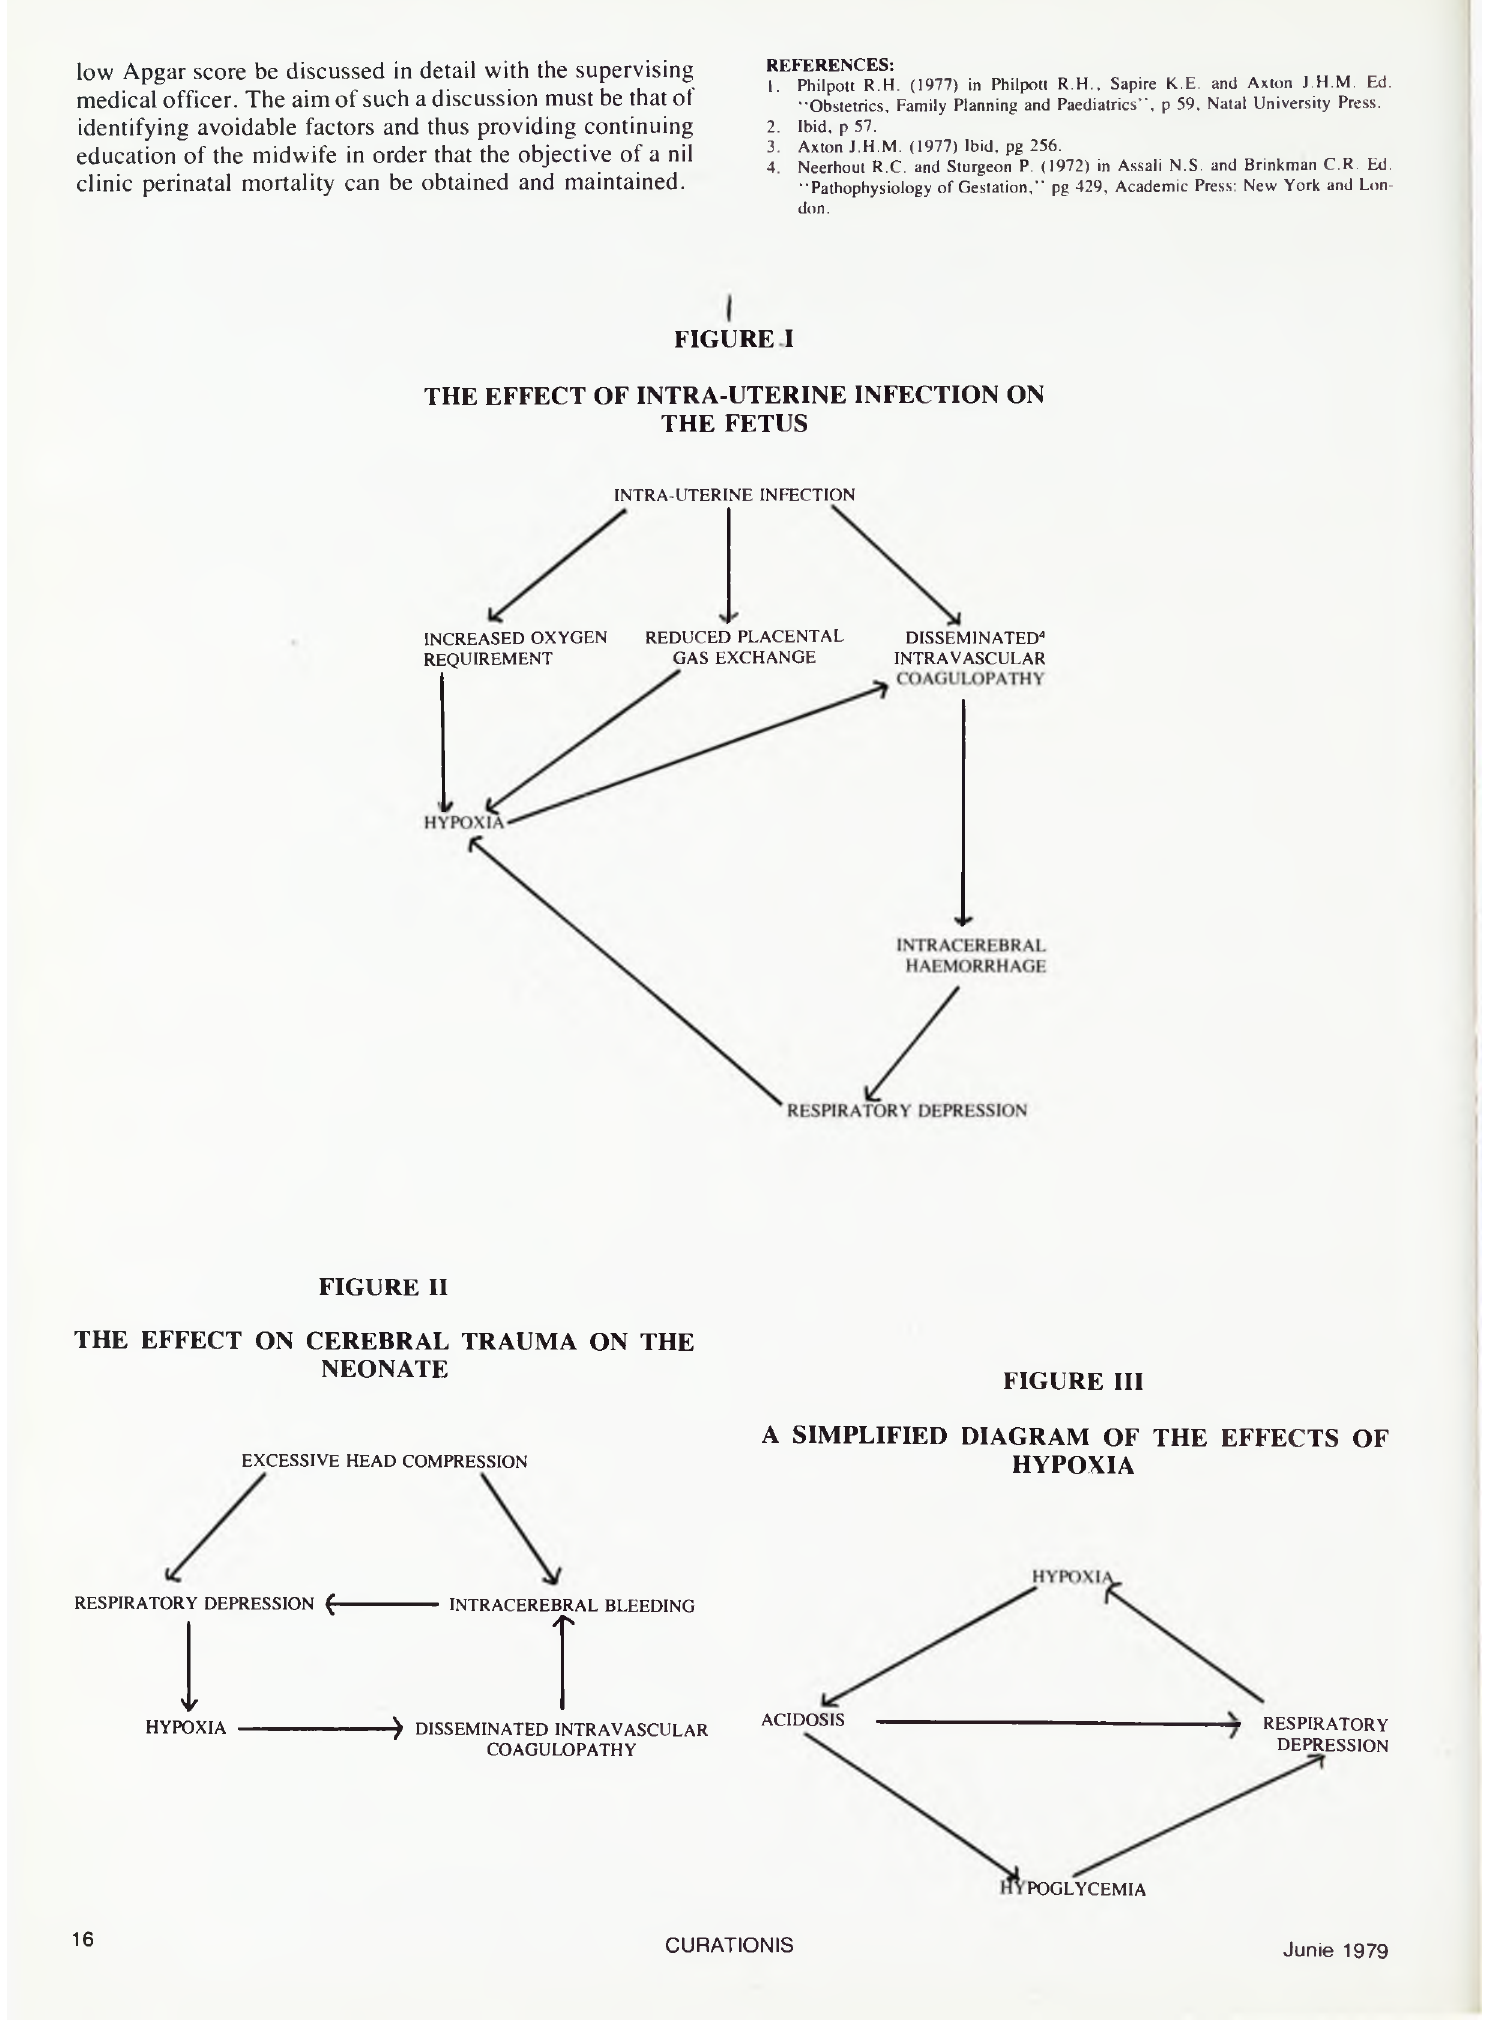
THE EFFECT OF INTRA-UTERINE INFECTION ON THE FETUS INTRA-UTERINE INFECTION